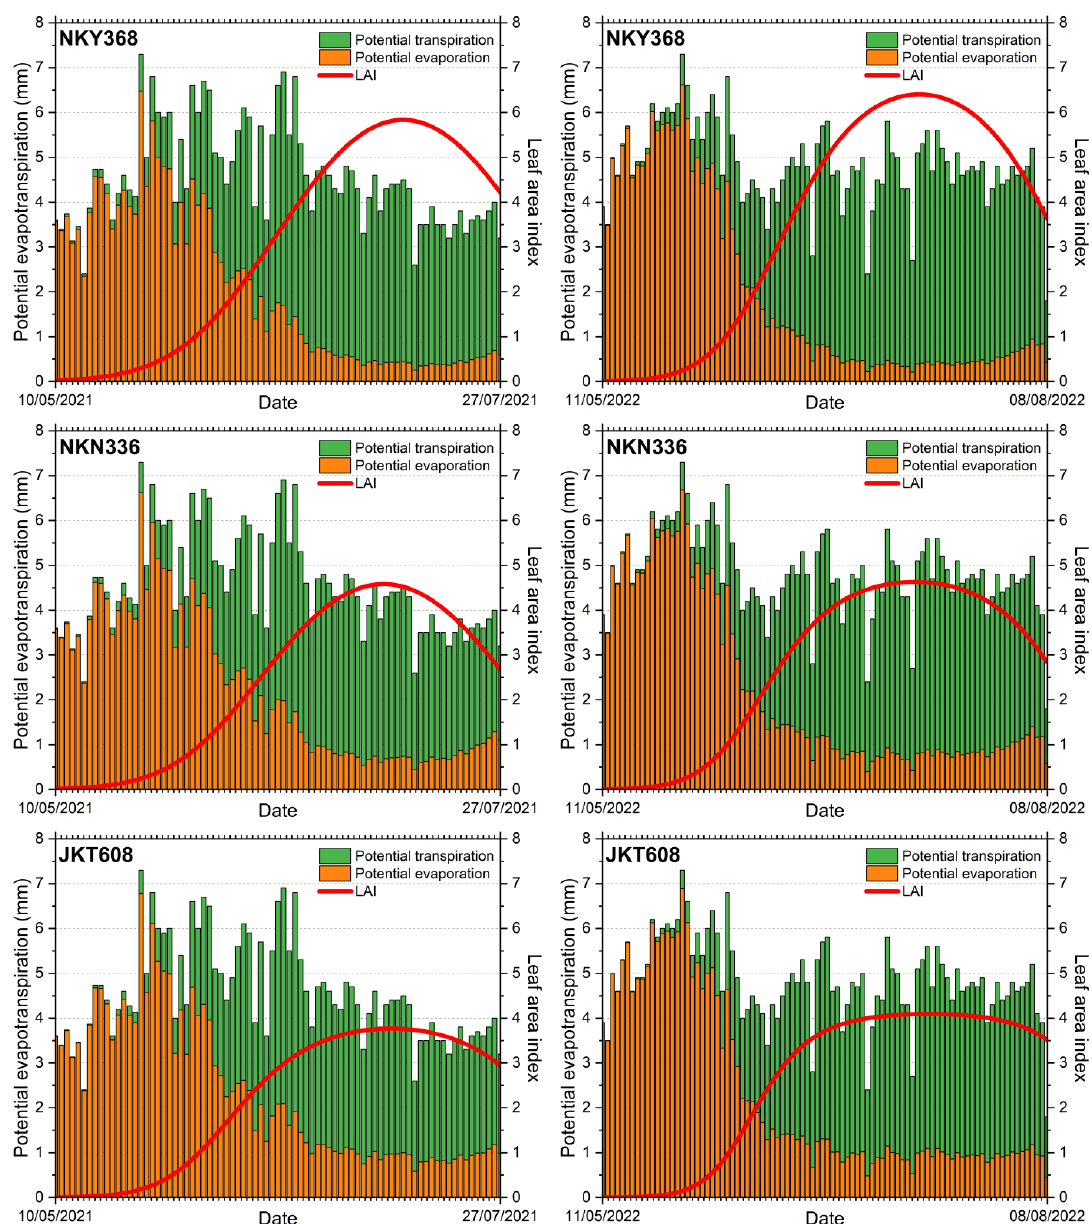
Figure 6. Trends in potential evapotranspiration rate and leaf area index (LAI) coefficient.